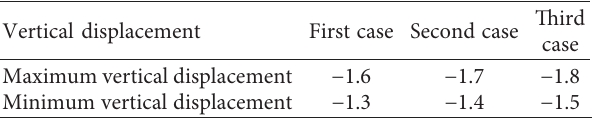
Figure 4: Nephograms of (a) lock chamber horizontal displacement, (b) vertical displacement, (c) first principal stress, and (d) and third principal stress in the first case; (e) lock chamber horizontal displacement, (f) vertical displacement, (g) first principal stress, and (h) third principal stress in the second case; and (i) lock chamber horizontal displacement, (j) vertical displacement, (k) first principal stress, and (l) third principal stress in the third Table 2: Minimum and maximum vertical displacements of the chamber under various operating conditions (unit: mm).